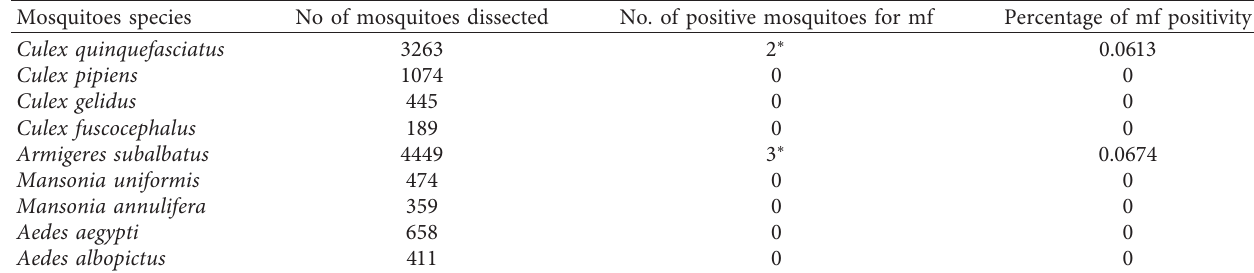
Table 5: Percentage of microfilaria (mf) positivity in adult